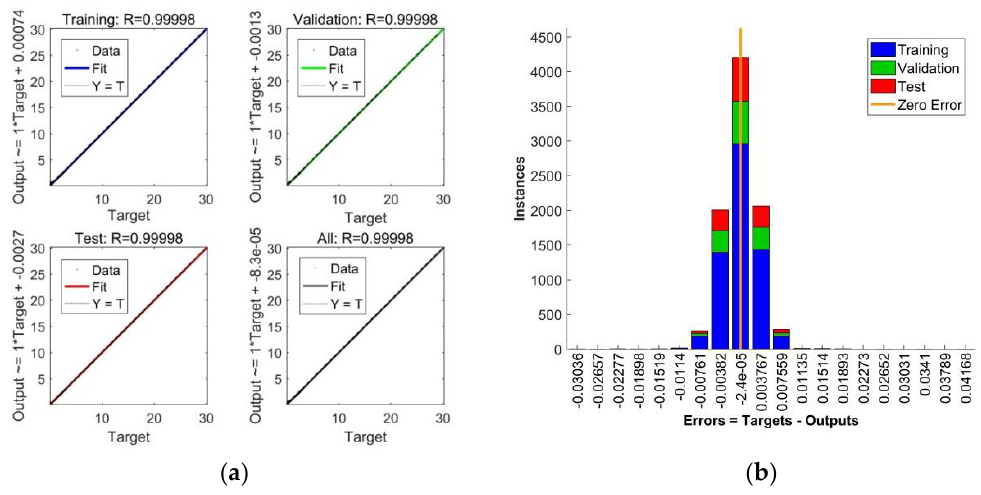
Figure 6. ( a ) Linear regression plots for training, validation, testing, and all data used in the optimization process; ( b ) Error histogram for training, validation and testing data.